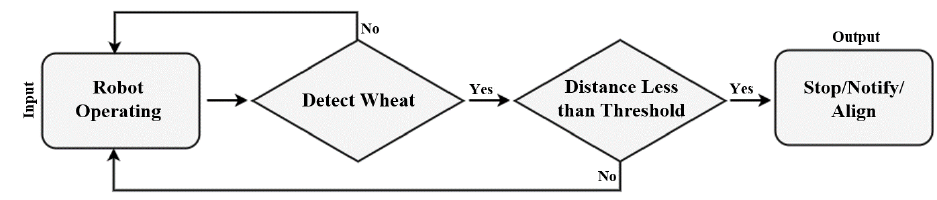
Figure 7. Workflow for robot’s operation and collision avoidance.